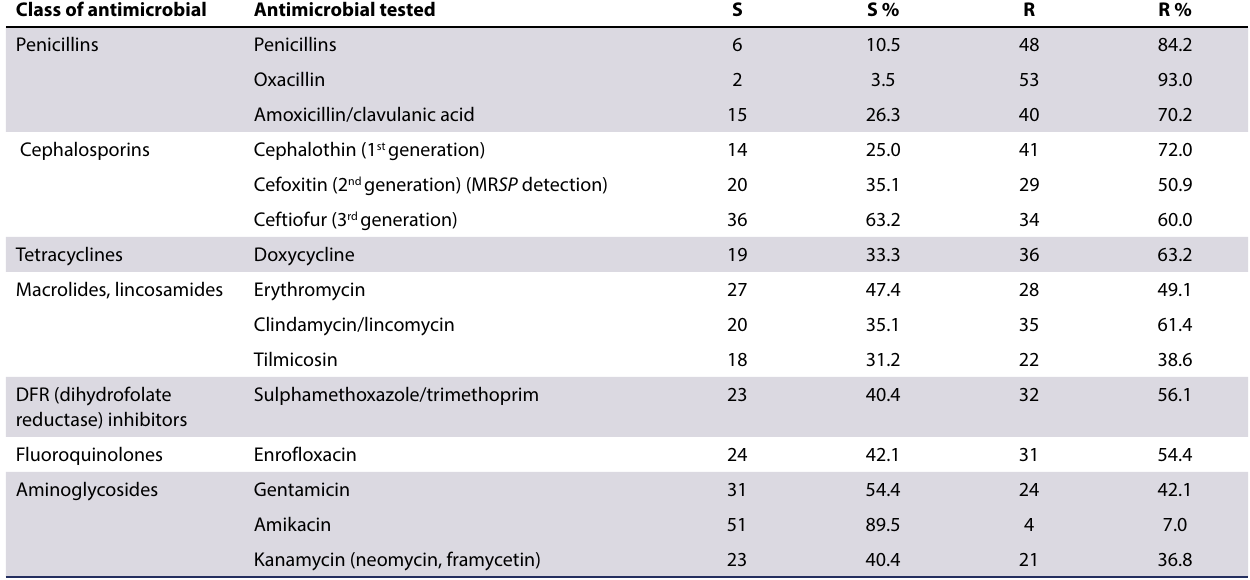
Table I: Antimicrobial resistance profile in Staphylococcus pseudintermedius clinical isolates ( n = 57) Class of